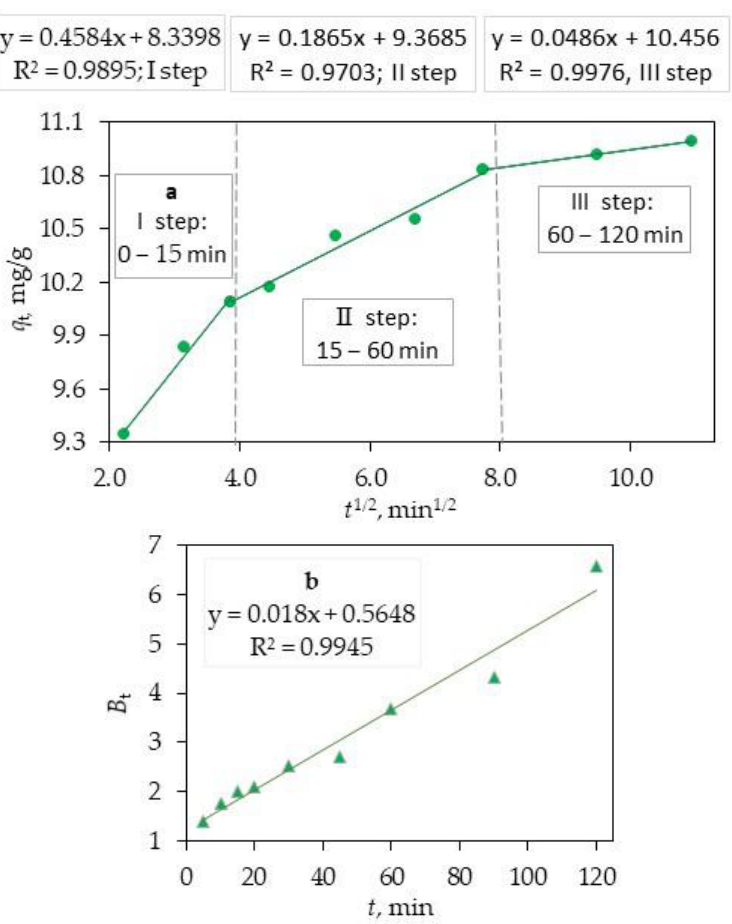
Figure 7. The adsorption kinetic data of CIP on the ternary core–shell Fe 3 O 4 /SiO 2 /TiO 2 nanocomposite fitted with Webe – Morris intraparticle diffusion ( a ) and Boyd diffusion models ( b ).